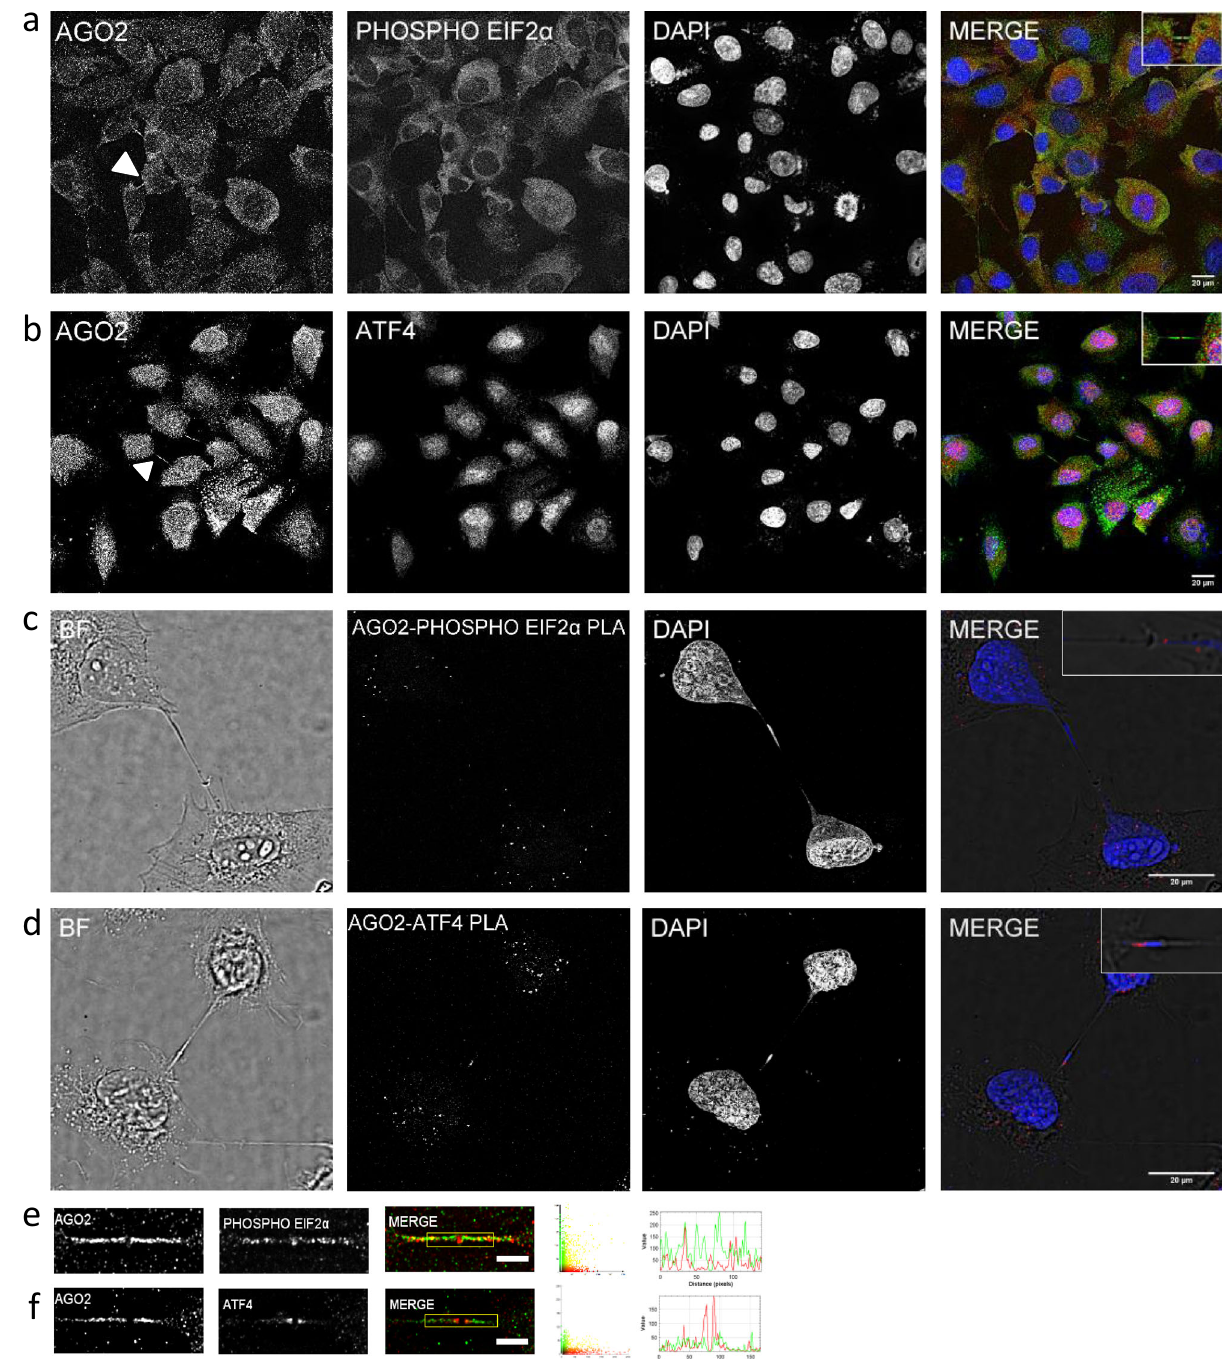
Fig. 10 Subcellular localization and interaction between AGO2 and ER-stress regulators. Representative images of NTHY ori 3-1 cells showing AGO2 colocalization with a phospho-Elf2 α and b ATF4. AGO2 proteins in green, phospho-EIf2 α and ATF4 in red. Nuclei of cells were visualized in blue (DAPI). iPLA foci between c AGO2-phospho-EIf2 α and d AGO2-ATF4 in red. e – f Visual assessment (merged images, scatterplots, and intensity lineplots) of colocalization. Lineplots indicate the signal intensity of the paired proteins along the lines overlaid on the corresponding images that appear in Supplementary Fig. S2e – f. Scale bar: 20 μ m (full images), 5 μ m (zoomed